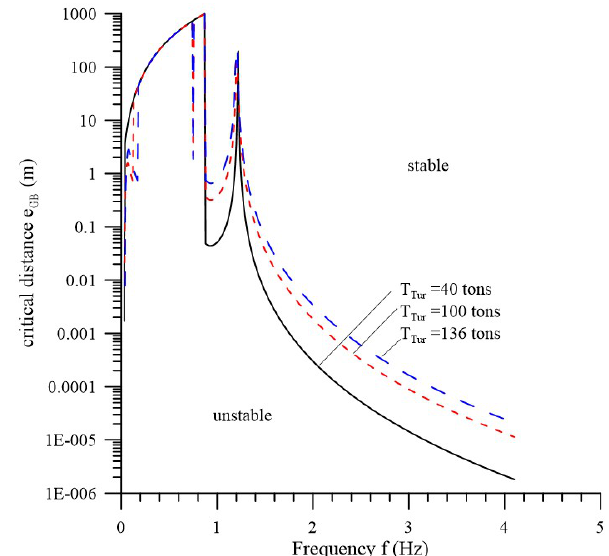
T on the critical distance between the centers Tur